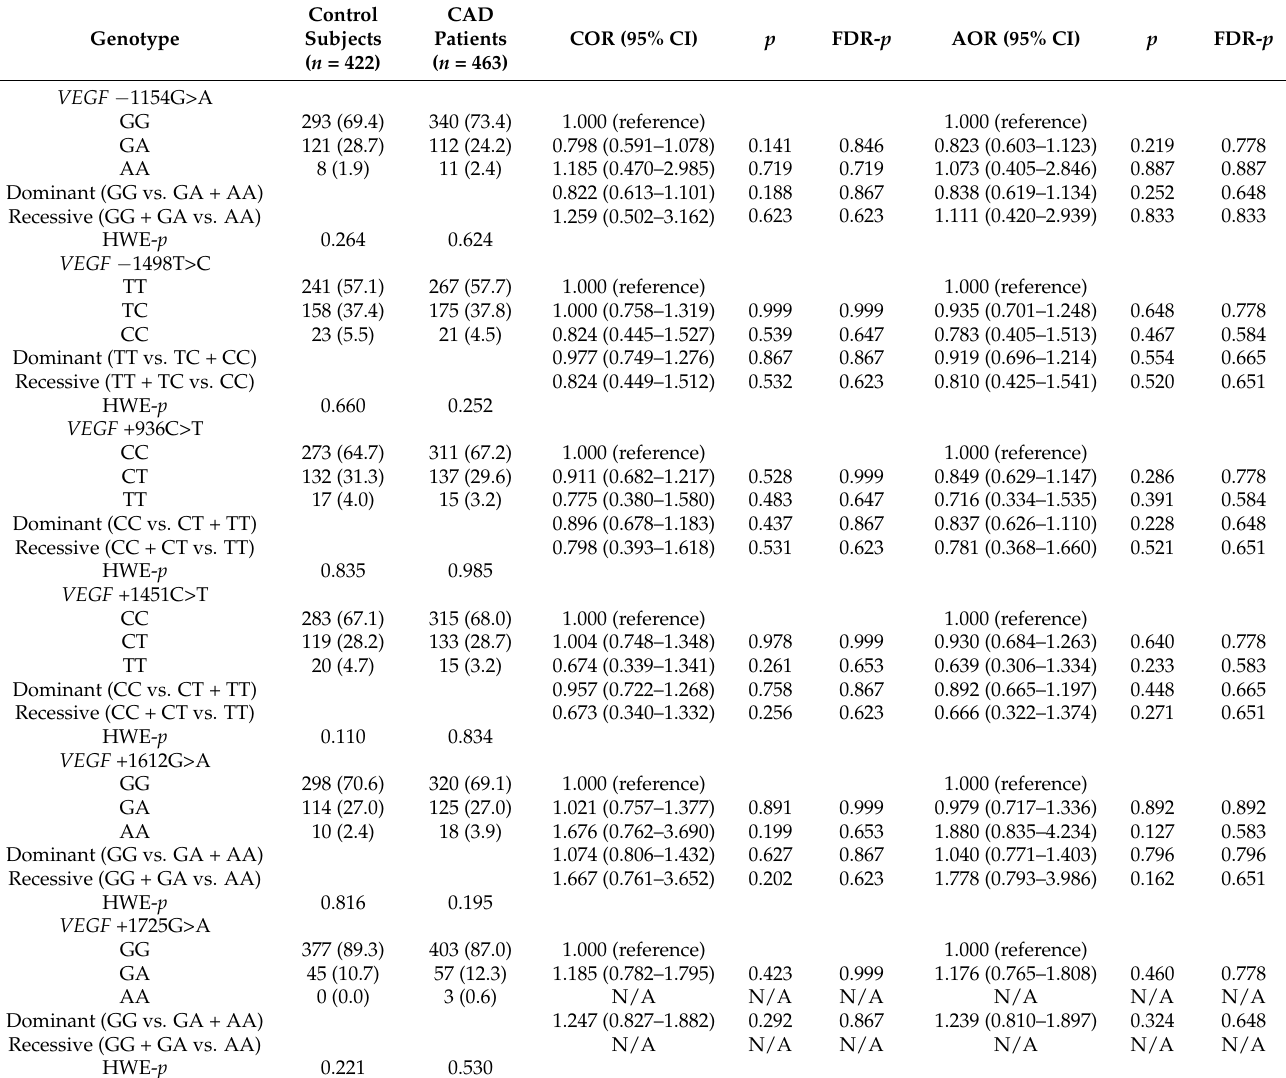
Table 2. Comparison of genotype frequencies of VEGF polymorphisms between CAD patients and control